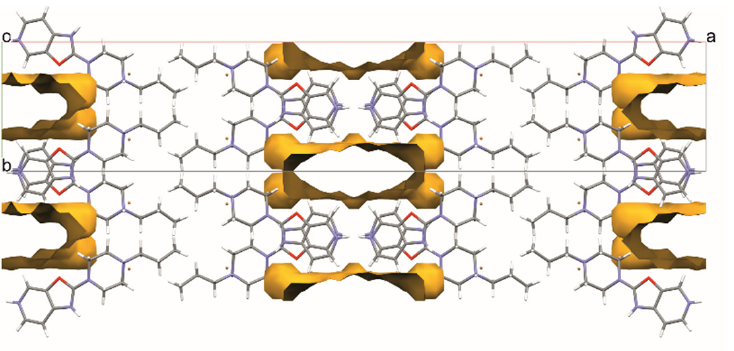
Figure 5. Voids identified by SQUEEZE procedure in structure 3. The voids contain disordered Br anions and possibly DMF and water molecules. The voids form channels across the crystal structure down the c axis.